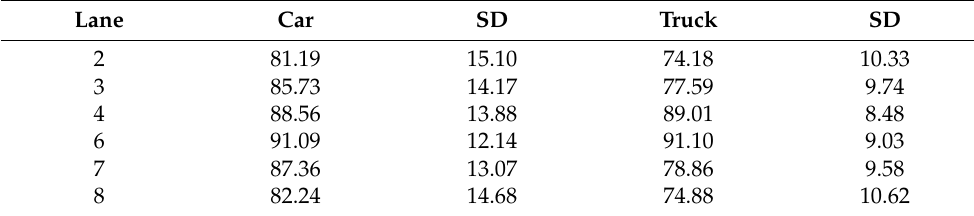
Table A1. The mean and standard deviation of velocity.